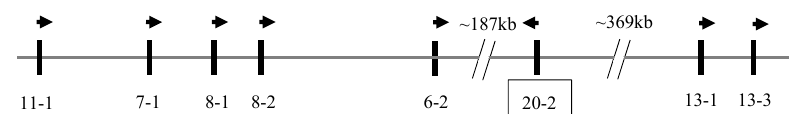
Figure 1. Location of the putative KRTAP20-2 (boxed), together with seven other KRTAPs on goat chromosome 1. The vertical bars represent the keratin-associated protein (KAP) genes, and the arrows indicate the direction of transcription. The numbers below these bars are the KAP gene names (e.g., 11-1 represents KRTAP11-1 ). The spacing of the genes is only approximate, and is based on the caprine genome assembly, as are the nucleotide coordinates